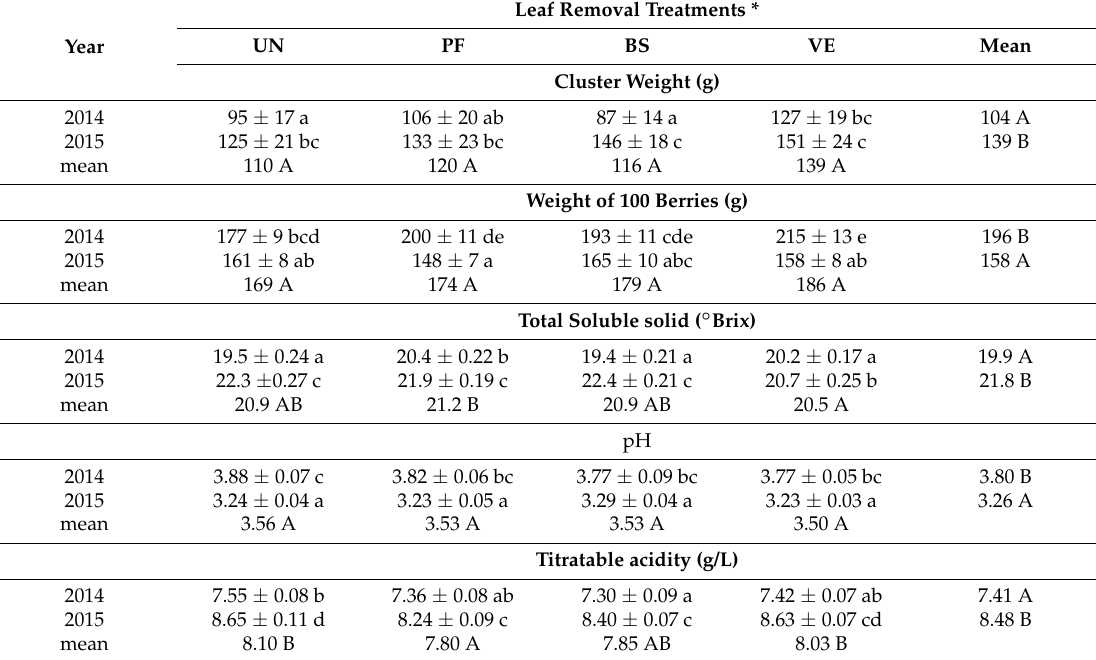
Table 2. General parameters of grape cultivar Regent as related to different leaf removal